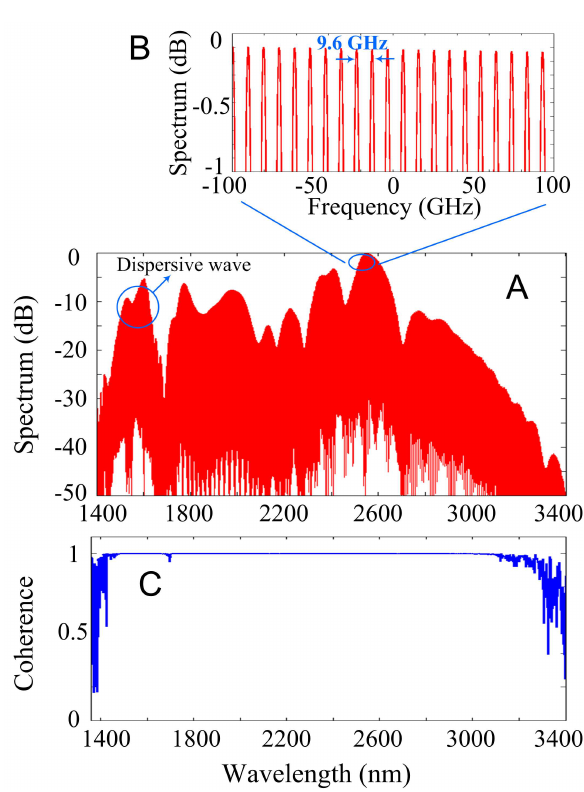
Figure 14: (A) The spectral profiles of the pulse train after propa- gation inside the 1 cm long SOI waveguide, (B) zoom-in view of the spectral component centered at 2520 nm with 200 GHz bandwidth, and (C) the SC coherence as a function of the wavelength. The pa- rameters α = 0.1 dB/cm, 𝛾 = 45 W −1 /m, β 3PA = 2.5 × 10 −26 m 3 /W 2 , σ = 2.77 × 10 −21 m 2 , and ζ = −2.7 × 10 −27 m 3